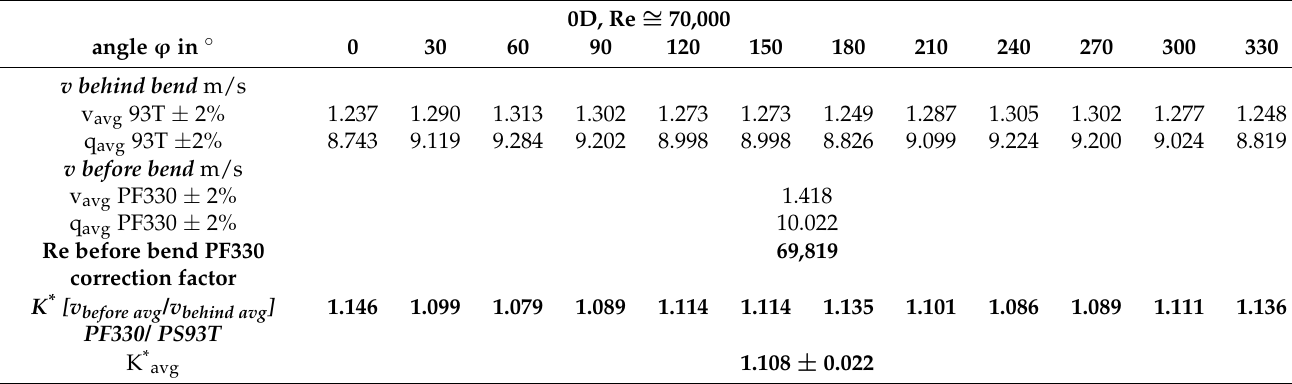
Table 3. Summary of the results of ultrasonic measurements for the 0D plane from the disturbing element as a function of the mounting angle of the ultrasonic flow meter sensors, Re ∼ = 70,000.